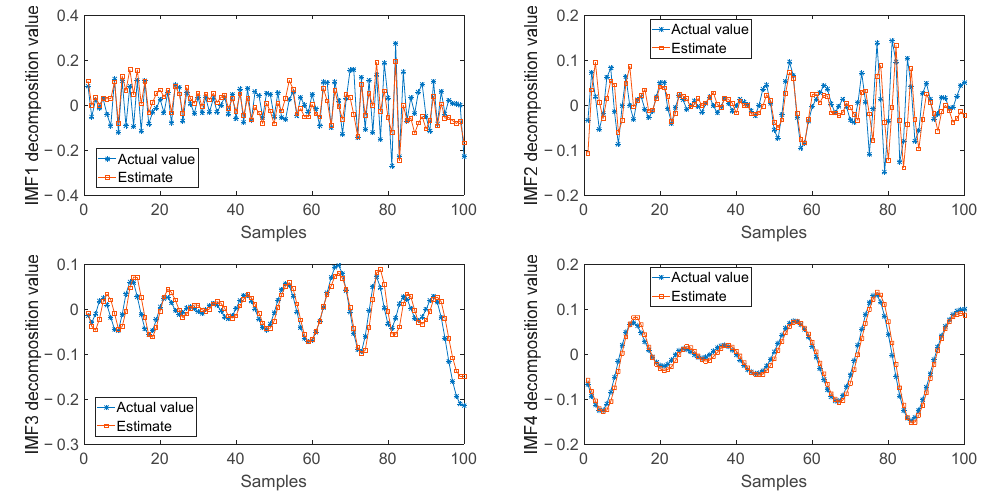
Figure 11. The predictive comparison of IMF1, IMF2, IMF3 and IMF4 components.